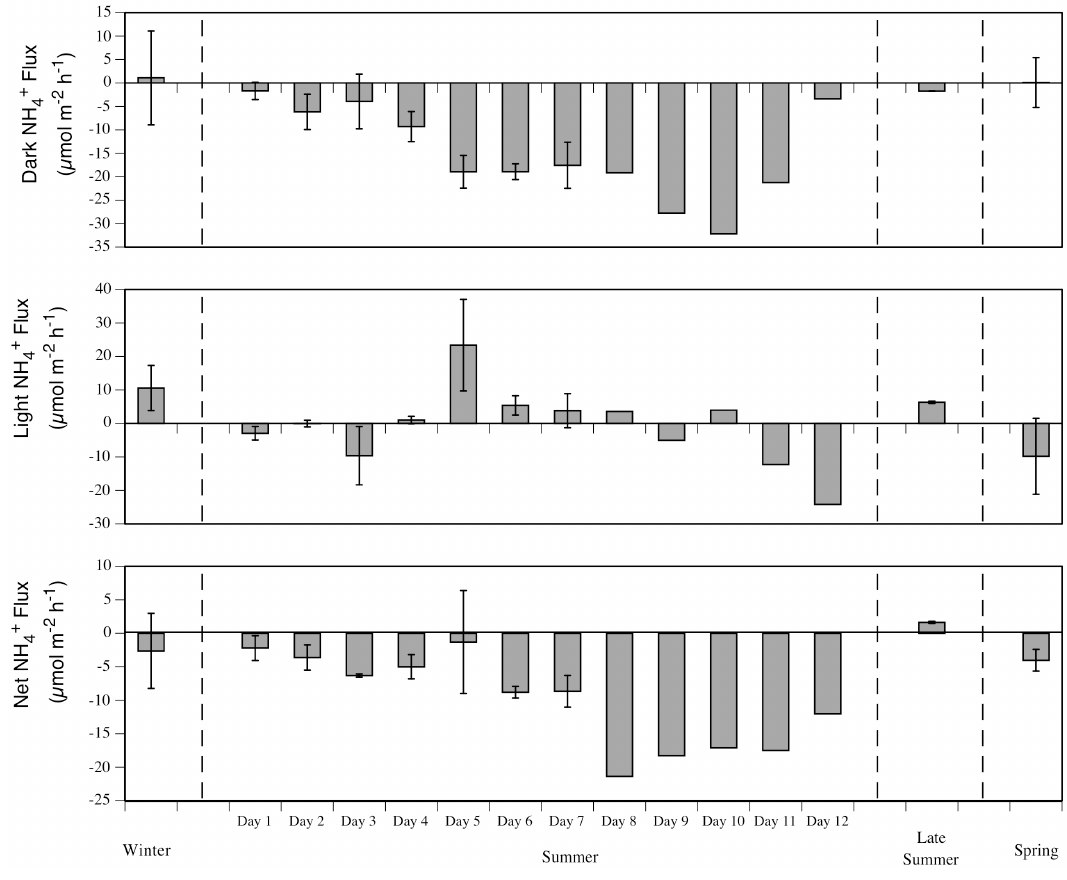
) fluxes (mean ± SE where replicated; see Table 1). 4